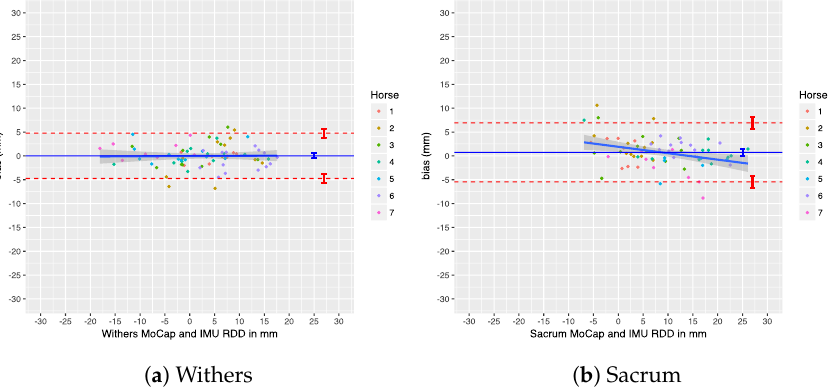
Figure 26. Bland–Altman analysis for Range_diff